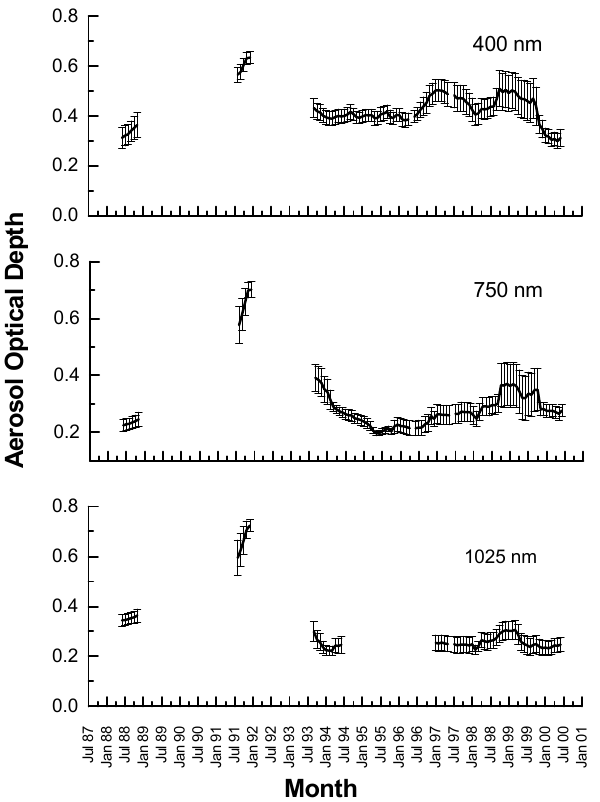
Fig. 1. Temporal variation of the 13-point running mean aerosol optical depth at 400nm, 750nm and 1025nm. The vertical bars represent the standard deviation of the mean.